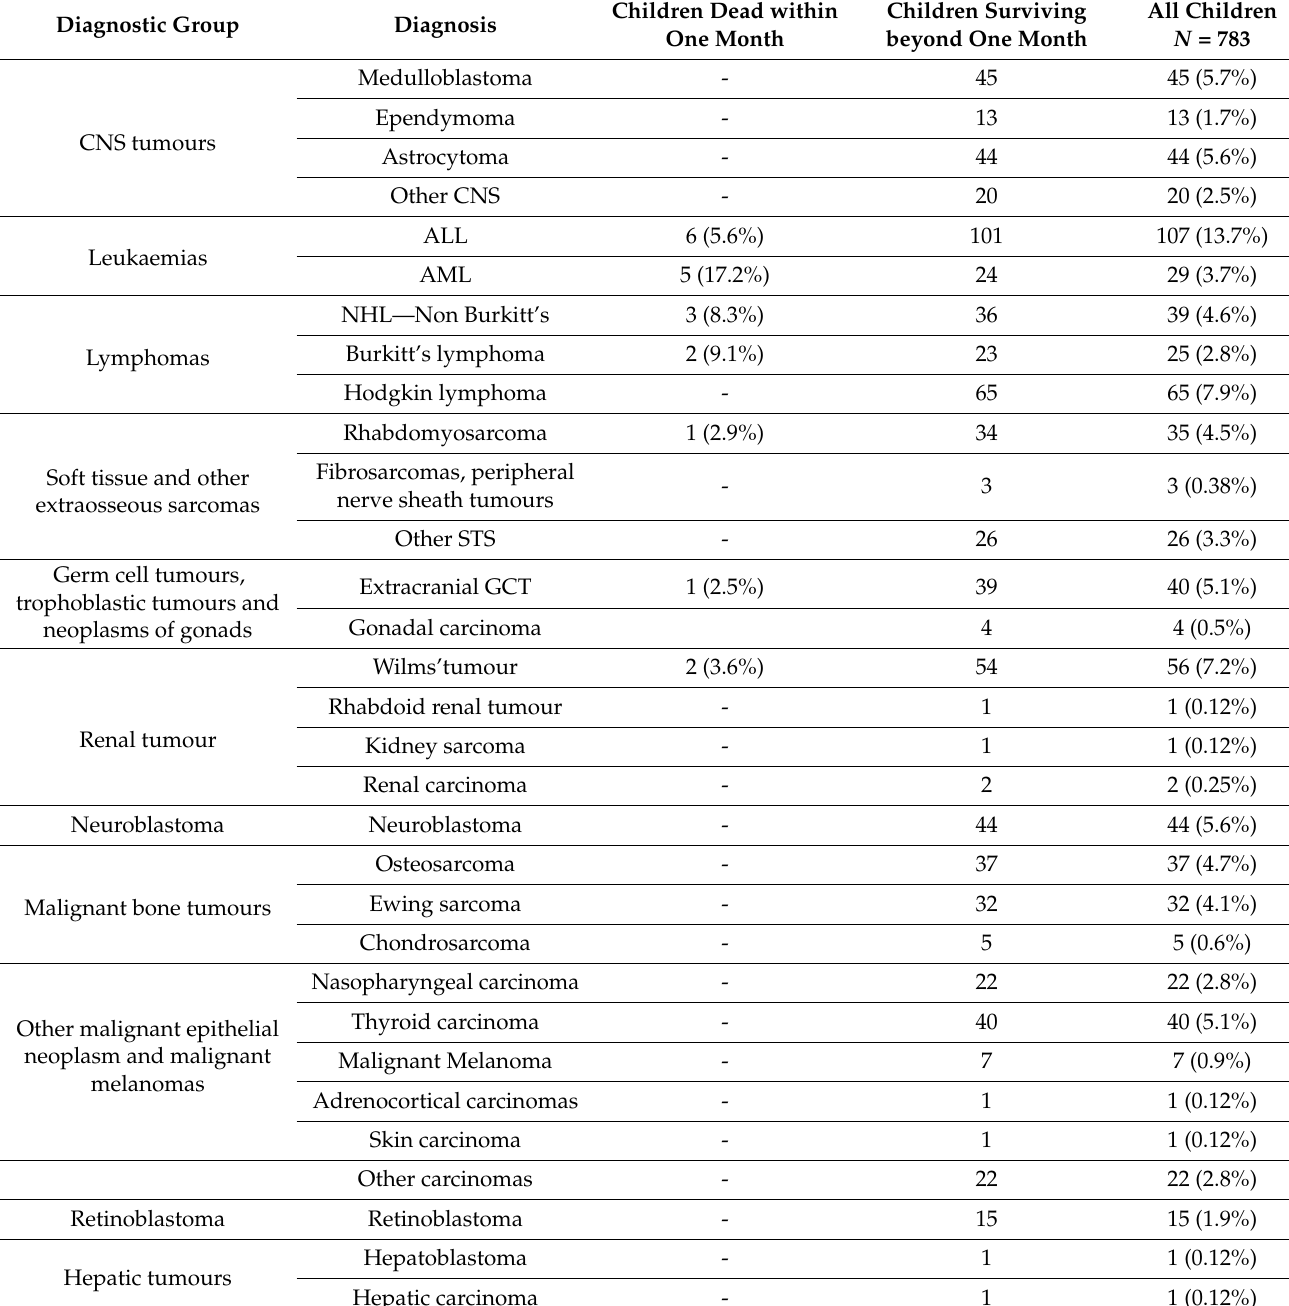
Table 2. Mortality percentage by tumour